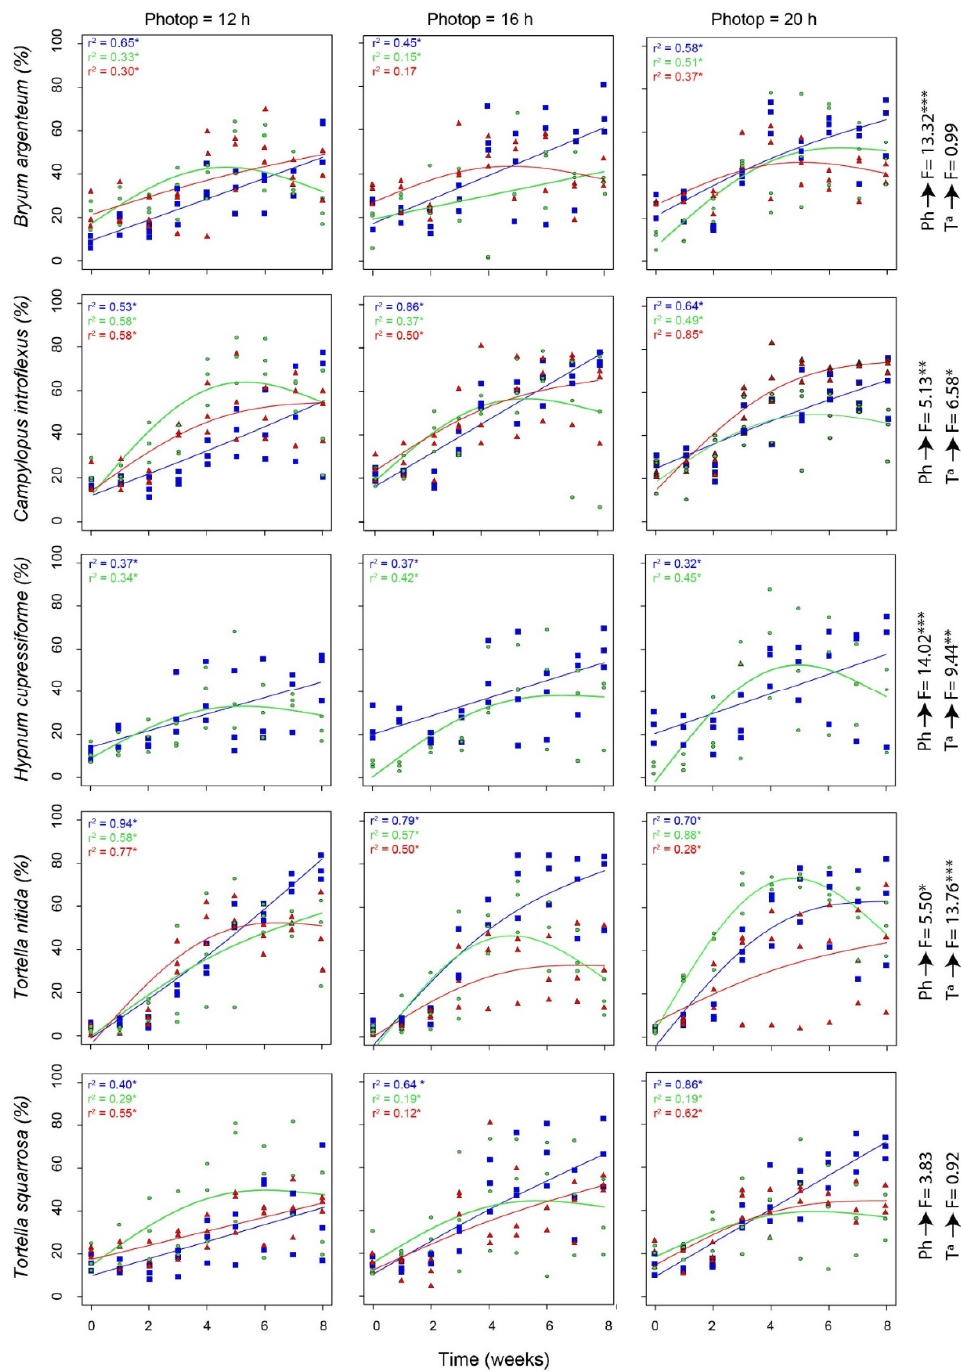
Figure 1. Tendency of a generalized additive model (GAM) for the coverage of the different moss species and the photoperiods and the different temperatures (Solid lines: blue = 15 °C, green = 20 °C and red = 25 °C), adjusted r 2 , F-value (F) for both variables and p -value (*** p < 0.001; ** p < 0.01; * p < 0.05).